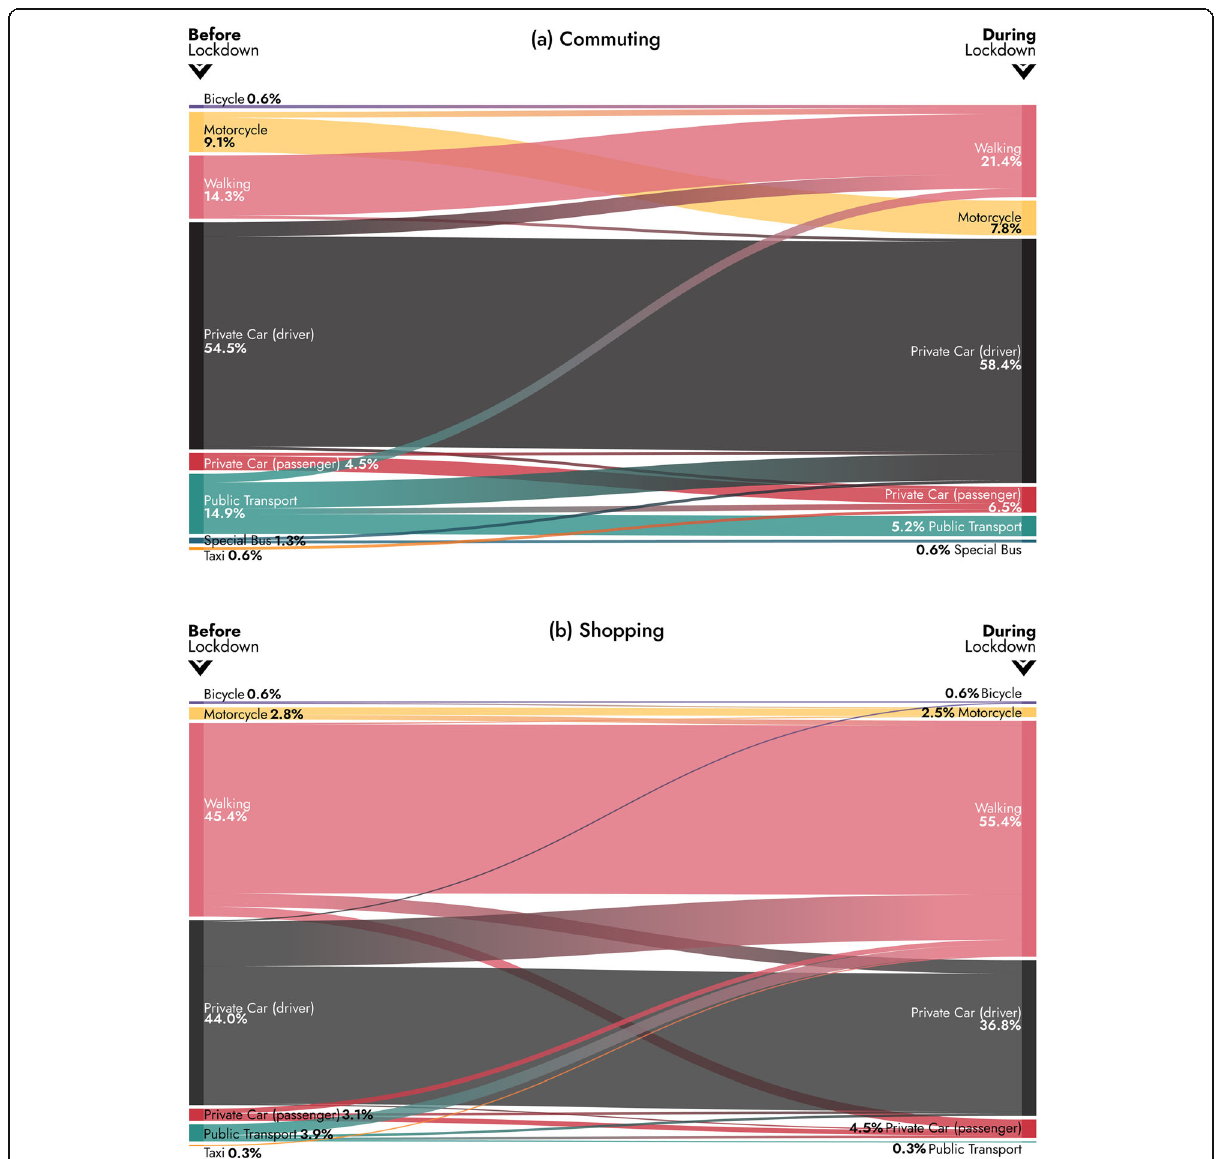
Fig. 4 Flows between transport mode use before and during the imposition of lockdown measures for commuting and